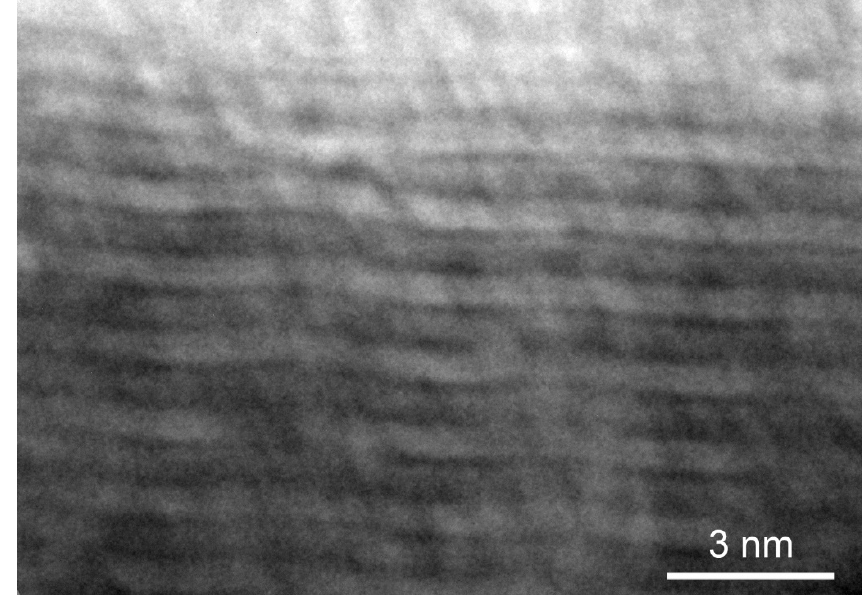
Figure 14. High-resolution transmission electron microscopy (TEM) image showing undulations in the PbS-type ( Q ) and MoS 2 -type ( H ) layers, which are stacked along the c -axis. Sample (3666qx A grid A2) prepared by ultramicrotome. The length of the scale bar is approximate.